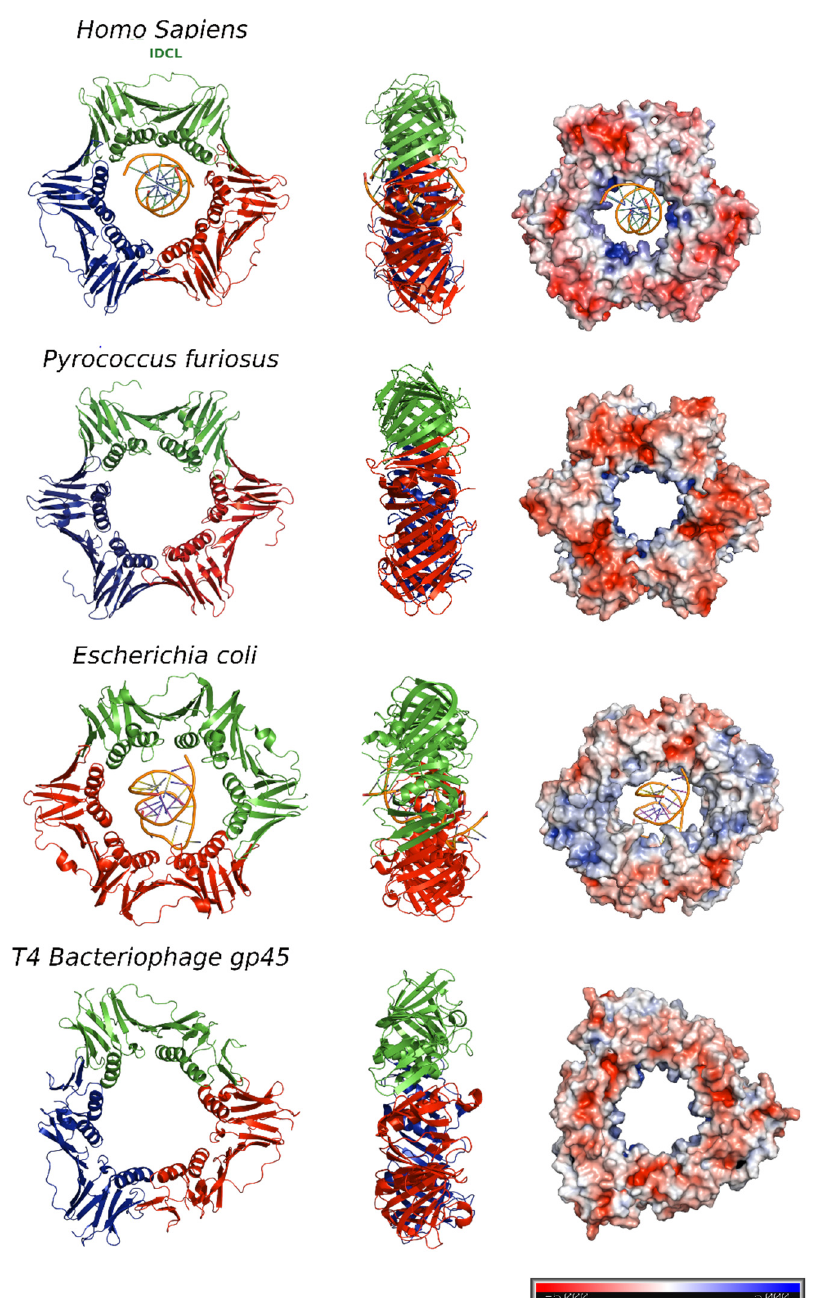
Figure 2. DNA sliding clamps from di ff erent organisms. The crystal structures of Homo sapiens PCNA (Protein Data Bank [PDB] code: 6GIS) bound to DNA, Pyrococcus furiosus PCNA (PDB code:1GE8), the Escherichia coli β clamp (PDB code: 3BEP) bound to DNA, and the gene 45 antigen of Bacteriophage T4 (PDB code: 1CZD). For each organism, the front (left) and side views (middle) of the three-dimensional crystal structure are shown. Each protomer is represented by a di ff erent color (blue, red and green). The surface electrostatic potential is represented, with positive potential depicted in blue and negative potential in red (right). The potential varies from − 5K B T / e to + 5K B T / e. The central pore has an internal diameter of approximately 35 Å, larger than the 24 Å of the double stranded DNA helix (dsDNA) in the canonical B-form [13]. Overall, clamps are acidic proteins α -helices facing the central cavity are rich in positively charged amino acids and generate a